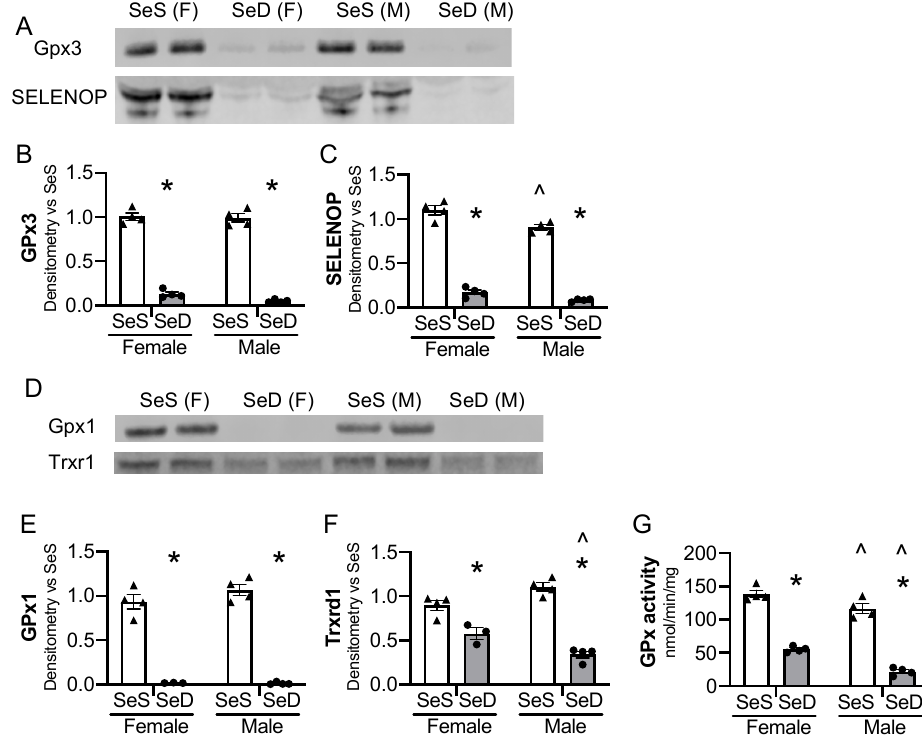
Figure 1. Breeding pairs on a Se deficient diet exhibit diminished selenoenzyme protein content and activity. C57Bl/6 mice were placed on diets that differed only in Se content, either 0.4 ppm or <0.01 ppm of sodium selenite for 2–4 weeks. Female and male breeders were assessed for Se status. ( A ) Representative blots of plasma GPx3 and SELENOP, assessed in 2 µ L plasma. Densitometry results are normalized to total protein stain and expressed as a ratio to SeS control. Densitometric analysis of ( B ) GPx3, ( C ) SELENOP. Hepatic whole organ homogenate was evaluated. ( D ) Representative blots of hepatic Trxrd1 and Gpx1. Densitometry results are normalized to total protein stain and expressed as a ratio to SeS control. Densitometric analysis of ( E ) GPx1 and ( F ) Trxrd1 ( G ) Glutathione peroxidase activity level by oxidation of NADPH per minute per mg of protein. N = 4 for all groups. Data are presented as mean ( ± SEM), * p < 0.05 vs. sex-matched SeS control by multiple comparisons after two-way ANOVA, ∧ p < 0.05 vs. diet-matched F by multiple comparisons after two-way ANOVA.